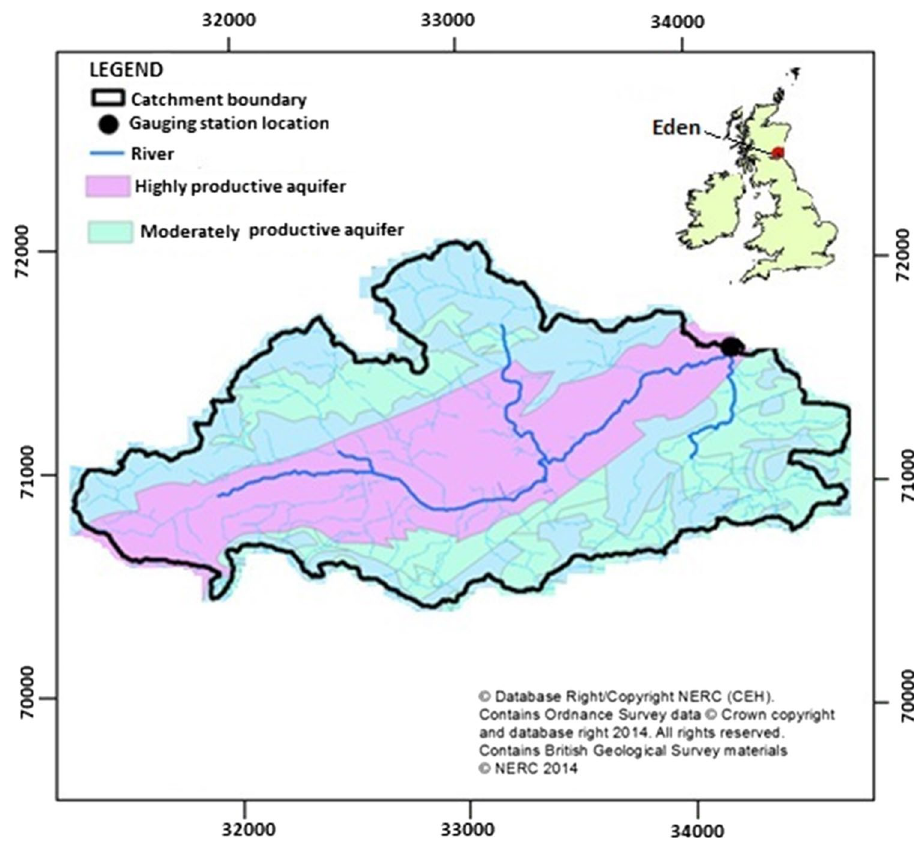
Fig. 1 Eden catchment bound- ary, stream route, gauging station location, location of the catchment on the UK map with hydrogeology of the catchment. Source: Morris et al. (1990); Morris and Flavin